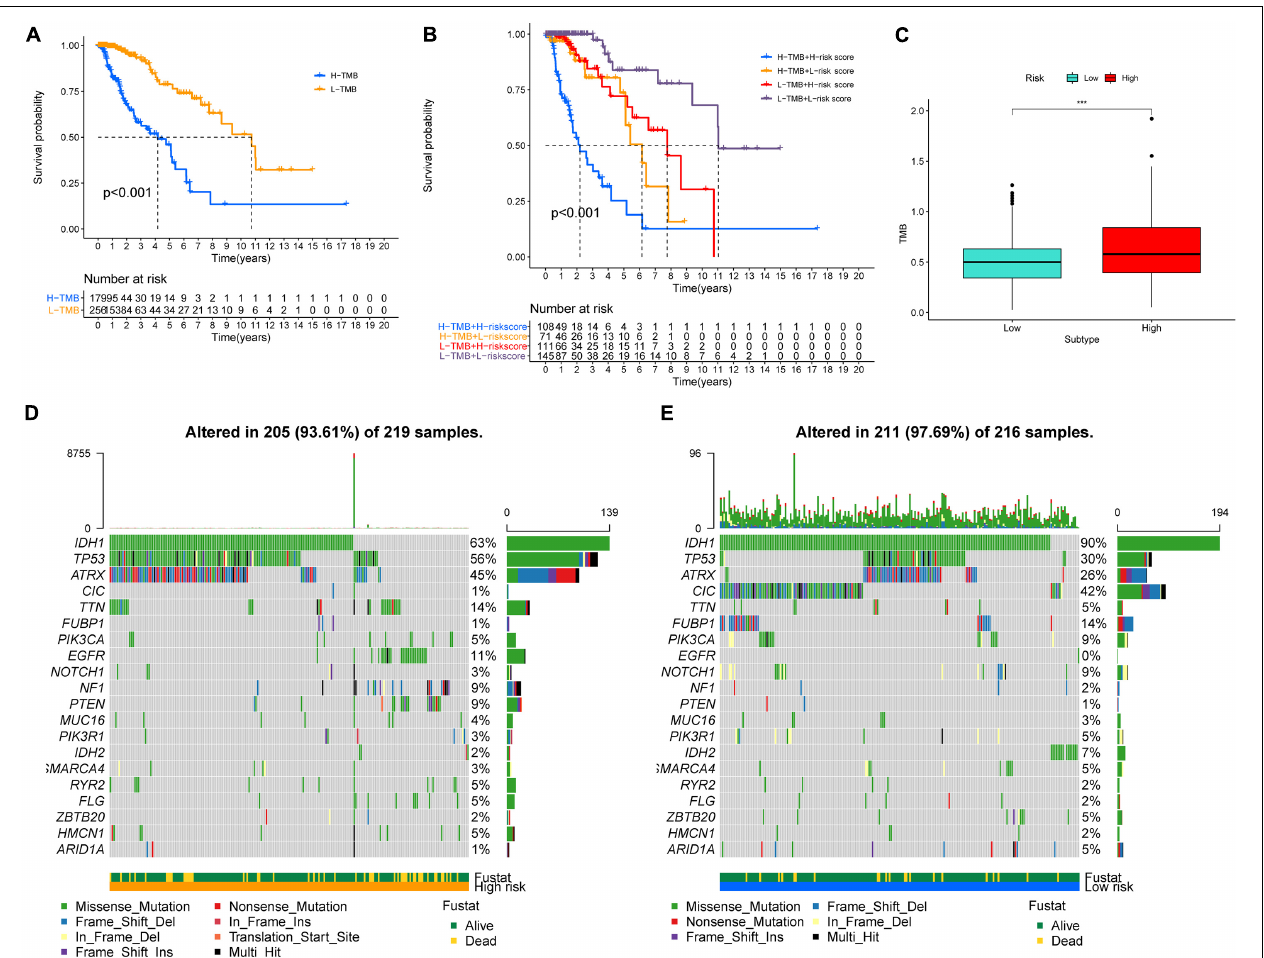
FIGURE 8 | Association between risk subtypes and TMB and mutation. (A) Survival analysis of TMB and OS of the patients with LGG in TCGA. (B) K–M curves of TMB combining with risk score in TCGA-LGG. (C) Difference analysis of TMB among low- and high-risk subtypes in LGG patients. (D) Top 30 highly mutated genes in LGG low-risk group. (E) Top 30 highly mutated genes in LGG high-risk group. *** p <